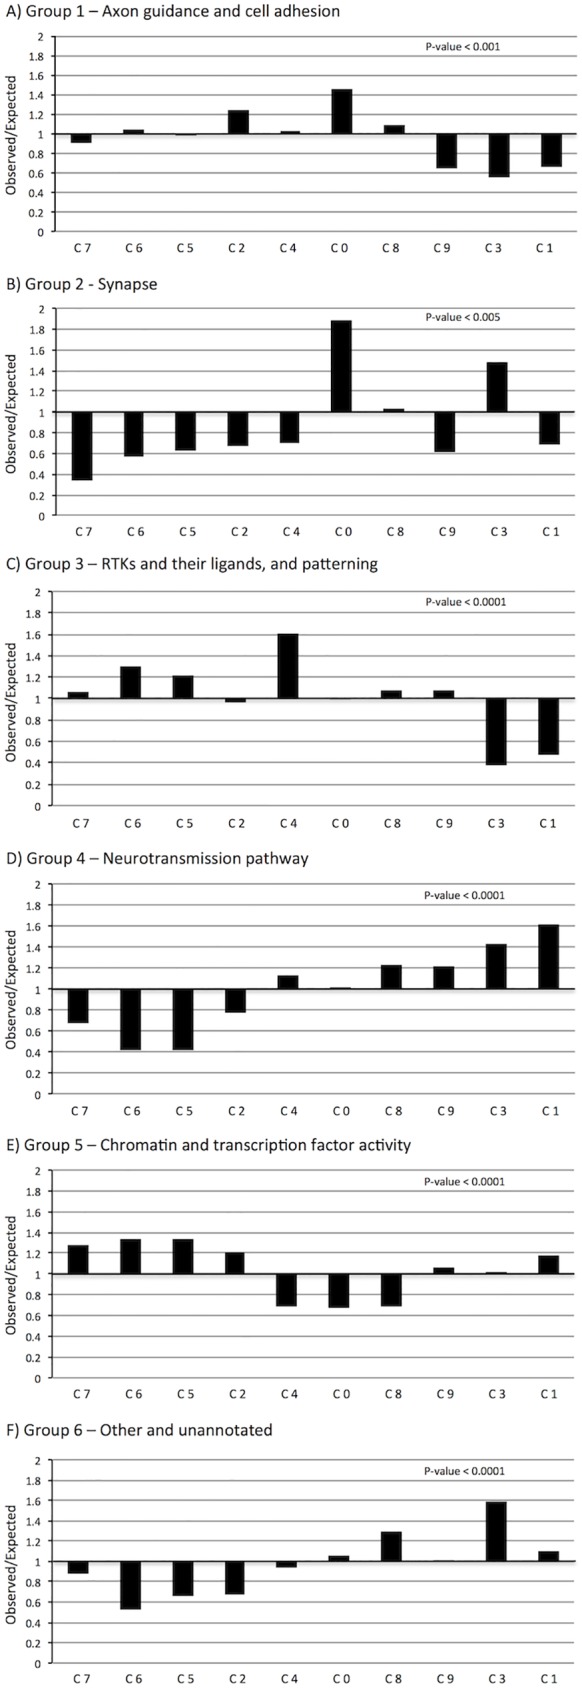
Enrichment of functional groups across clusters.Relative enrichment across clusters is shown by plotting observed/expected numbers of proteins per cluster for each of six groups: Group 1—axon guidance pathway and cell adhesion (A); Group 2—synapse (B); Group 3—receptor tyrosine kinases and their ligands, and patterning (C); Group 4—neurotransmission pathway (GPCRs, ion channels, gap junctions; D); Group 5—chromatin and transcription factor activity (E); and, Group 6—other (cytoskeleton, extracellular matrix, myelin, metabolic enzymes and signal transduction) and unannotated (F). A value of 1 indicates observed data matches expected values, whereas a value below or above 1 indicates decreased or increased counts compared to expected values, respectively. Clusters 0–9 are organized chronologically. P-values from chi square analyses are shown in upper right corner of each graph. All groups showed statistically significant deviation from expected distributions.